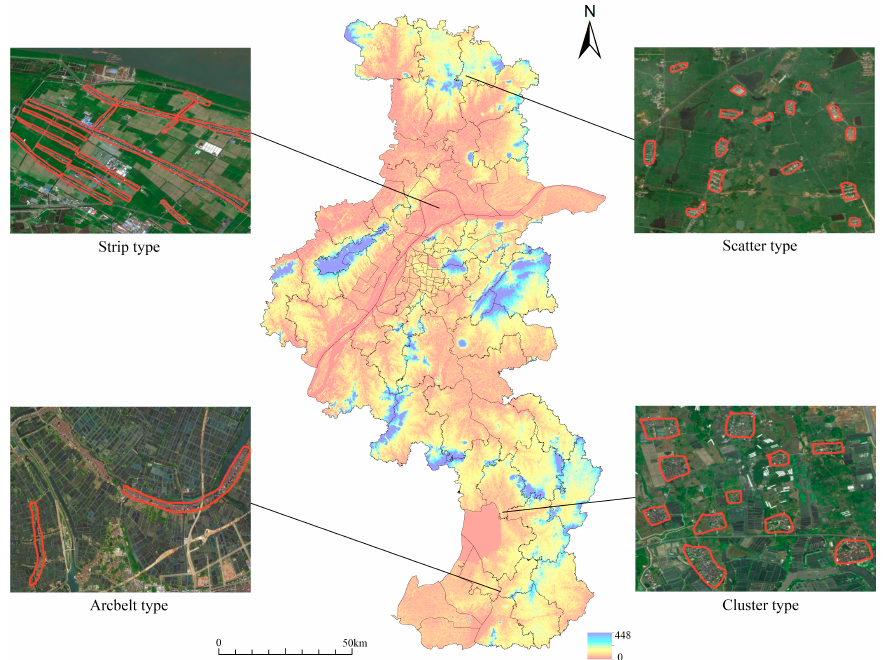
Figure 7. Distribution of rural settlement types in Nanjing.